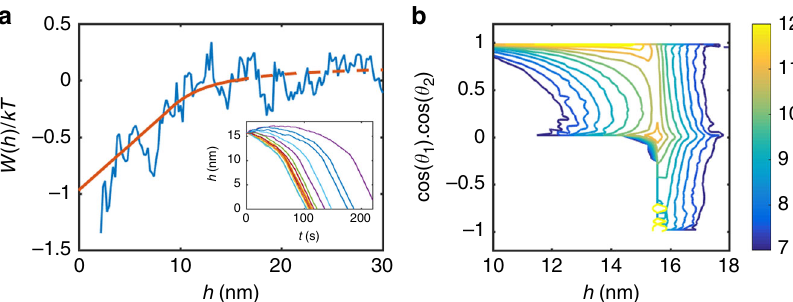
Fig. 6 Impact of dipole – dipole interactions on ZnO particle diffusion. a Experimental W(r) and corresponding two-piece fi t to a hyperbolic function at longer separations and linear function at shorter separations. Inset shows trajectories of individual particles. b The tendency for orientation as a function of edge-to-edge separation between two dipole particles over 10,000 ensembles with respect to the initial angles. Note that cos θ 1 cos θ 2 = 1 corresponds to the perfect “ head-to-tail ” attractive parallel alignment. Color scale denotes frequency of calculated